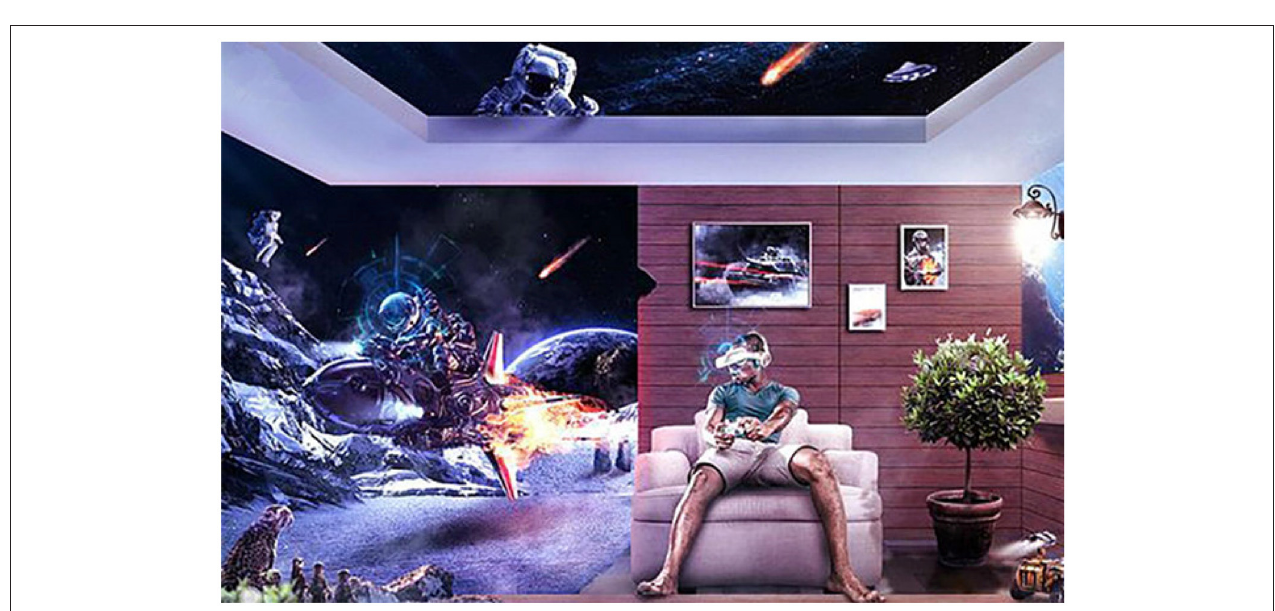
FIGURE 8 | Virtual tourism experience on site (http://alturl.com/g2aeg).